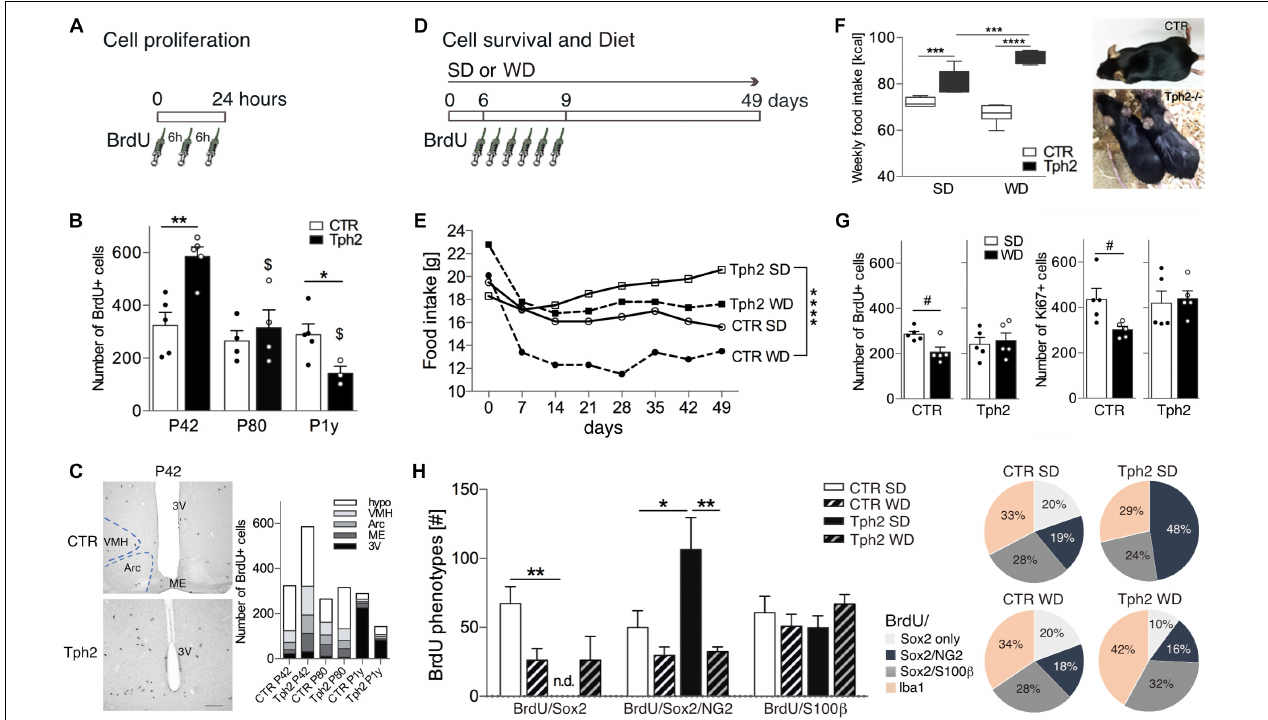
FIGURE 1 | Cell proliferation, food intake and cell survival at baseline and after Western-type diet (WD). (A) The number of BrdU-positive (BrdU + ) cells in the hypothalamic nuclei was quantified at 24 h after 3 injections of BrdU 6 h apart. (B) Cell proliferation (entire hypothalamus) was significantly higher in young-adult (P42) Tph2 − / − mice (Tph2), declined with aging and was significantly lower at 1 year of age (P1y) relative to littermates (CTR). (C) Representative images of BrdU peroxidase staining at P42, and cell numbers per hypothalamus (hypo; outside subnuclei) and per Arc, arcuate nucleus, VMH, ventromedial nucleus, ME, median eminence and 3V, third ventricle; Scale bar 150 µ m. (D) Three-month-old Tph2 and littermates (CTR) were subjected to either standard diet (SD) or WD and BrdU was injected on days 6, 7, 8, twice per day, to determine cell proliferation and cell survival 6 weeks later. (E,F) Average daily food intake was least in CTR and largest in Tph2 ( E , in g per cage of n = 5; F , in Kcal). Tph2 displayed oily and sticky fur upon WD. (G,H) At 49 days, WD resulted in a significant decrease in BrdU + and Ki67 + cells in the hypothalamus of CTR, while it had no effect in Tph2 ( G , Student’s t -test #p < 0.05). Decreased cell survival in CTR was reflected by a reduction in BrdU/Sox2 + cells, however, phenotype distribution was unaffected. In Tph2 under SD, half of cells co-express BrdU/Sox2/NG2, abolishing the number (graph) and percentage (pie diagram) of BrdU/Sox2-only cells (H) ; notably, this was not observed after WD. Two-way ANOVA followed by Tukey’s post hoc test ∗ p < 0.5, ∗∗ p < 0.01, ∗∗∗ p < 0.001, ∗∗∗∗ p < 0.0001 between genotypes, $ p < 0.05 to P42 of the same genotype.